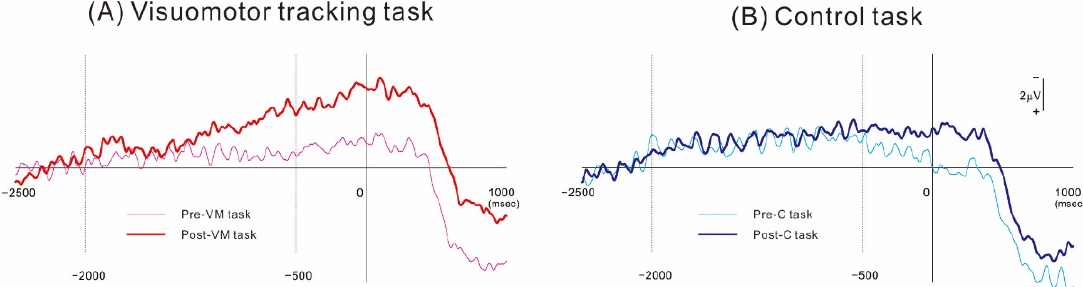
Figure 2. Grand-averaged MRCP waveforms obtained from over the ipsilesional motor cortex (C3 or C4 position of the 10–20 system). ( A ) MRCPs obtained before and after the visuomotor tracking task of motor intervention. ( B ) Corresponding MRCPs obtained before and after the control task. In both MRCP measurement conditions, the voltage deflection started about 2 s before movement onset. The MRCP amplitude was greater after the visuomotor tracking task but not after the control task.